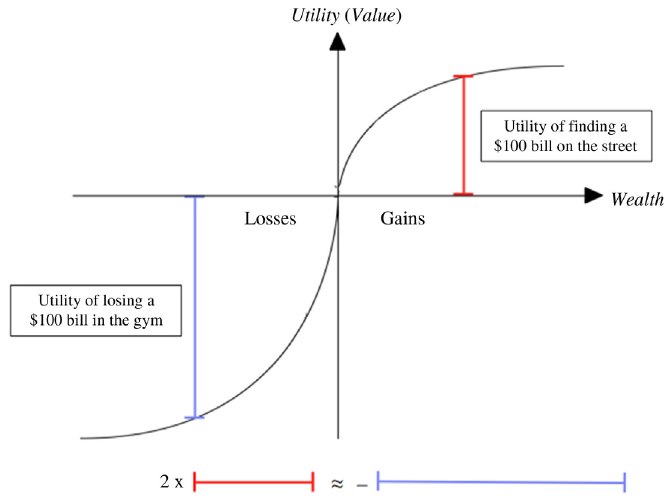
Figure 2. Value Function. The Utility of Losing and Finding $100